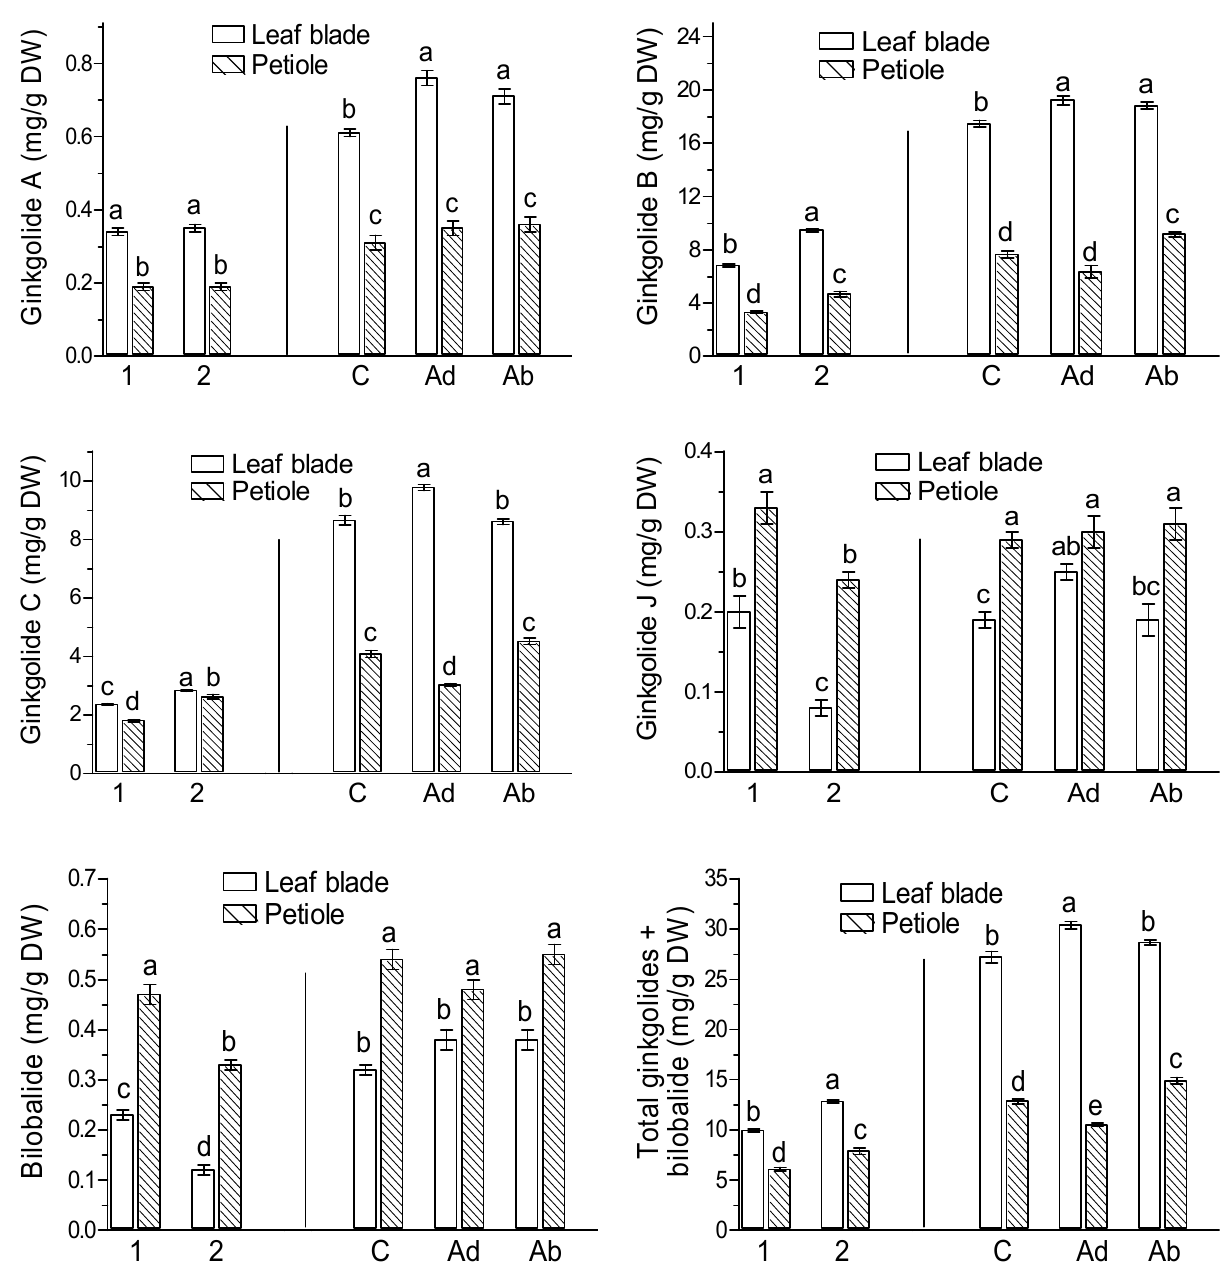
Figure 1. Effect of methyl jasmonate (JA-Me) on the content of ginkgolides and bilobalide in the leaf blade and petiole of G. biloba . Mean results ± SD followed by the same letter calculated for the natural senescence process and JA-Me treatment separately were not significantly different ( p < 0.05) according to Tukey’s test. Description of samples: 1, initial time (9 September); 2, naturally senesced yellow leaves (20 October); C, control (lanolin); Ad, JA-Me applied to the adaxial side of the leaf blade; Ab, JA-Me applied to the abaxial side of the leaf blade. C, Ad, and Ab samples were collected for analysis on 30 September.